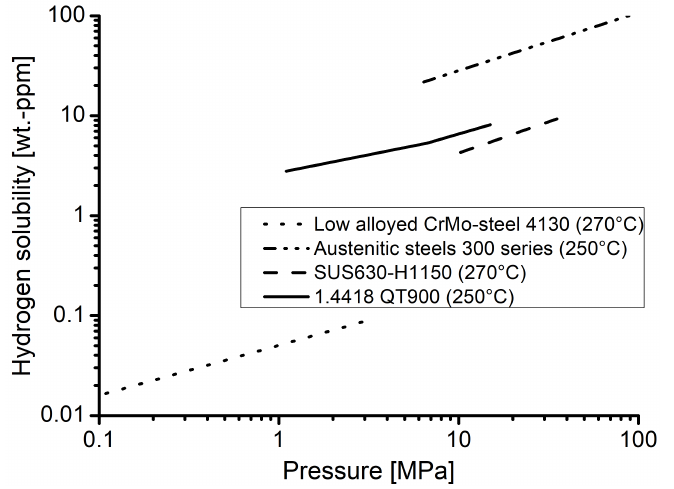
Figure 7. Hydrogen solubilities of the material 1.4418 in comparison to those for austenitic stainless steels [20] (both at 250 ◦ C ), a nickel martensitic maraging steel SUS630-H1150 [20] and a low alloyed CrMo-steel [21] (both at 270 ◦ C ).